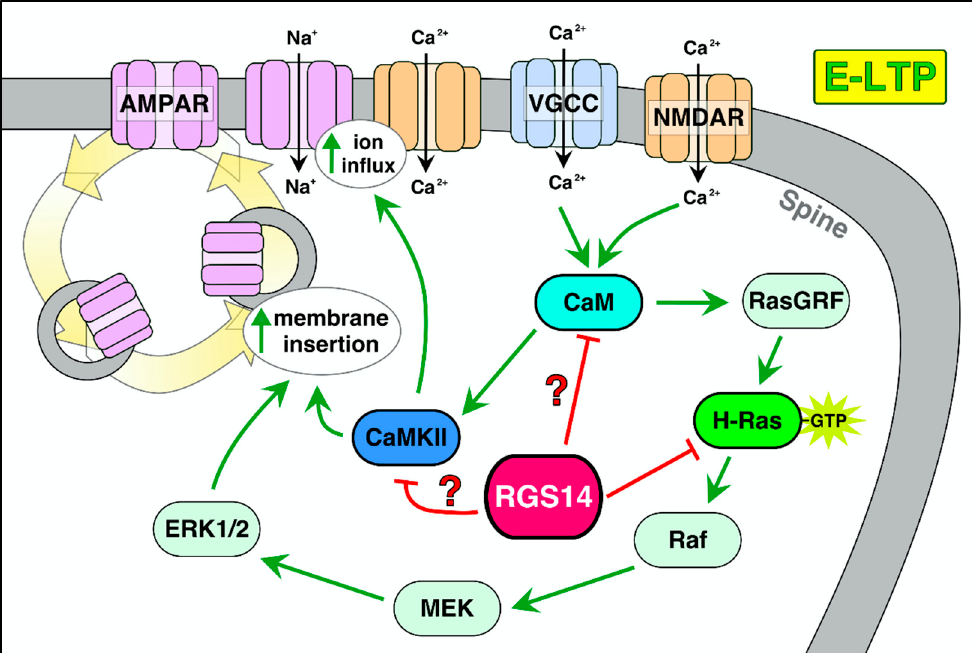
Figure 5. RGS14 regulation of early LTP. RGS14 limits Ca 2+ signaling during LTP induction, potentially through direct interaction with Ca 2+ /CaM and/or CaMKII. RGS14 also directly binds activated H-Ras–GTP and Ca 2+ /CaM likely to dampen ERK/MAPK signaling. RGS14 inhibition of Ca 2+ and MAPK signaling may curtail CaMKII- and ERK1/2-mediatied AMPAR membrane insertion and AMPAR and NMDAR channel potentiation to inhibit early long-term potentiation